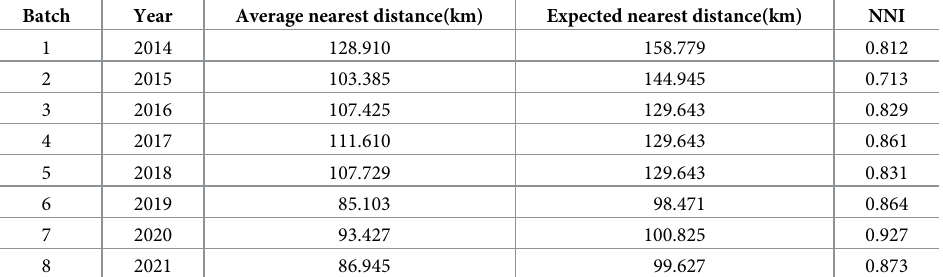
Table 2. Nearest neighbor distance index of beautiful leisure villages distribution. Batch Year Average nearest distance(km) Expected nearest distance(km)